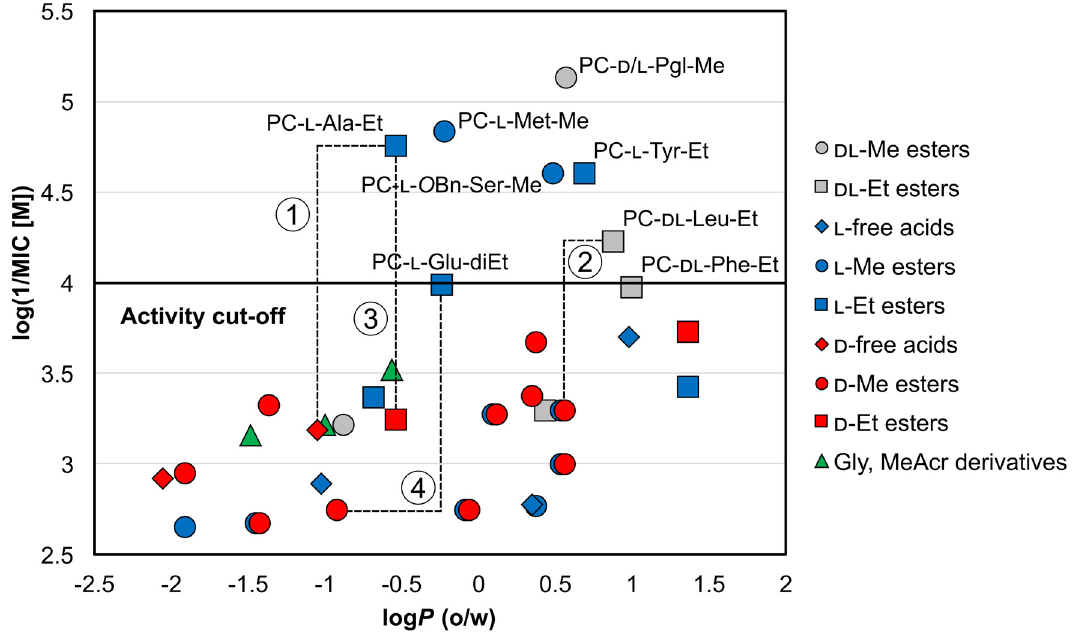
Figure 3. Scatter plot representing antimycobacterial activity and calculated lipophilicity of the compounds. The colours denote stereochemistry; the shape of the symbols distinguishes between esters and free acids. Gly and MeAcr derivatives are presented as green triangles. The MIC values of the majority of the derivatives in the non-active region were not determined precisely (see Table 3).